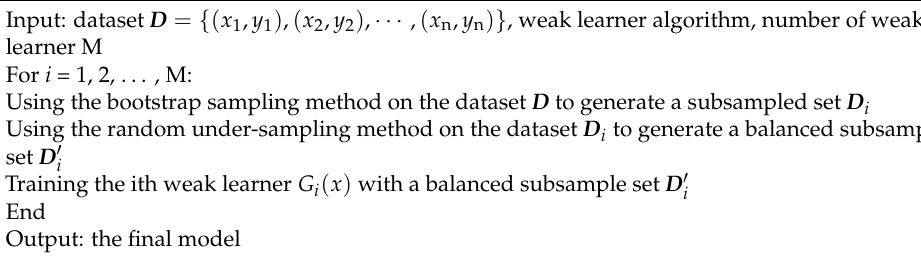
Table 1. Algorithm of the random under-sampling bagging method.